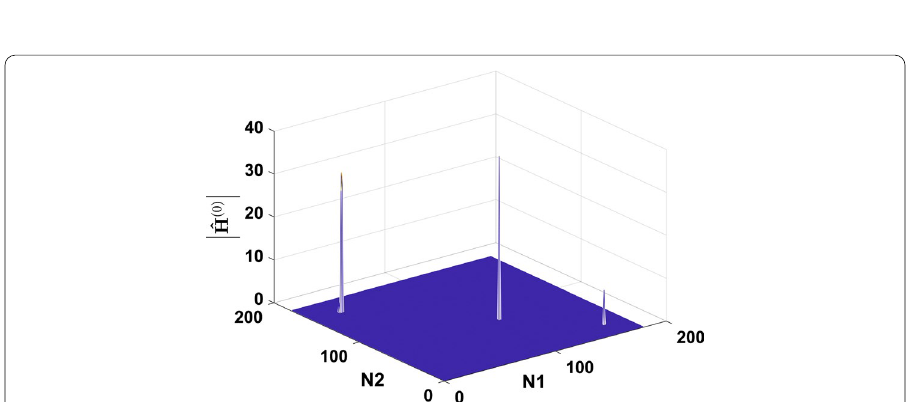
Fig. 2 Instance diagram, ˜ L = 3 , N 1 = N 2 = 180 . Sparse channel matrix can be showed under the under the DFT basis by this figure